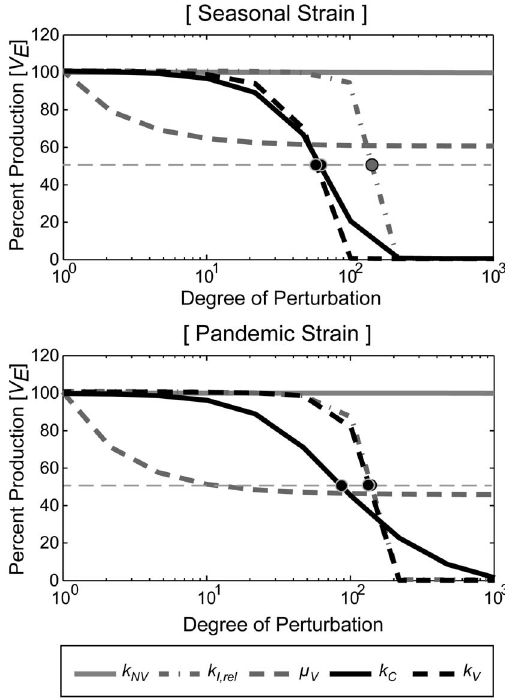
Figure 5. Kinetic analysis of parameter perturbations on the influenza production. For the seasonal and pandemic strains, the kinetic behaviors of each parameter perturbations were simulated. The parameter perturbations were performed 24 hours after infection, and the relative reduction in the viral production compared to the control simulations were measured after 50 hours of infection. The thin gray dotted line indicates the 50% inhibition of the viral production.